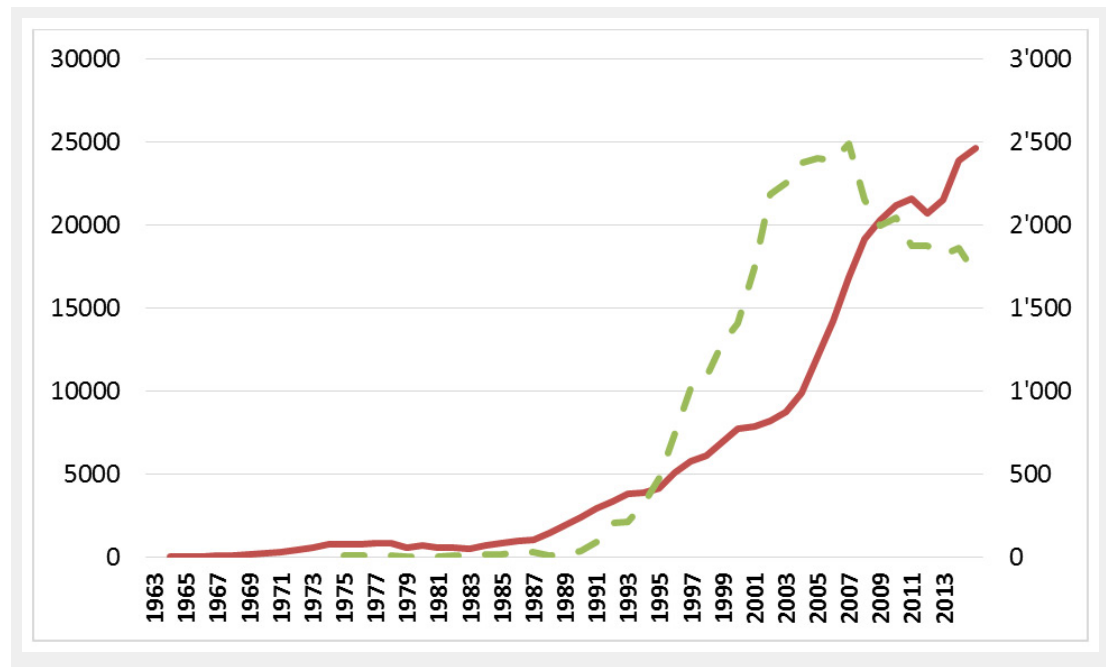
Figure 3 Evolution of publications about “biomedical informatics” compared with “genetic therapy” according to Pubmed. This figure illustrates the evolution of publications indexed in Pubmed with the MeSH term “medical informatics [MeSH]” (left axis, full line red) and “genetic therapy [MeSH]” (right axis, dotted line grey) between 1963 and 2013 as of 3 March 2015. The years 2014 and 2015 are left out to avoid bias of publication and indexing